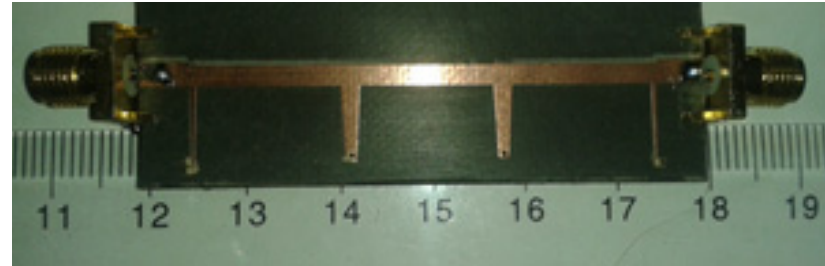
Figure 13. Photograph of the designed UWB BPF.